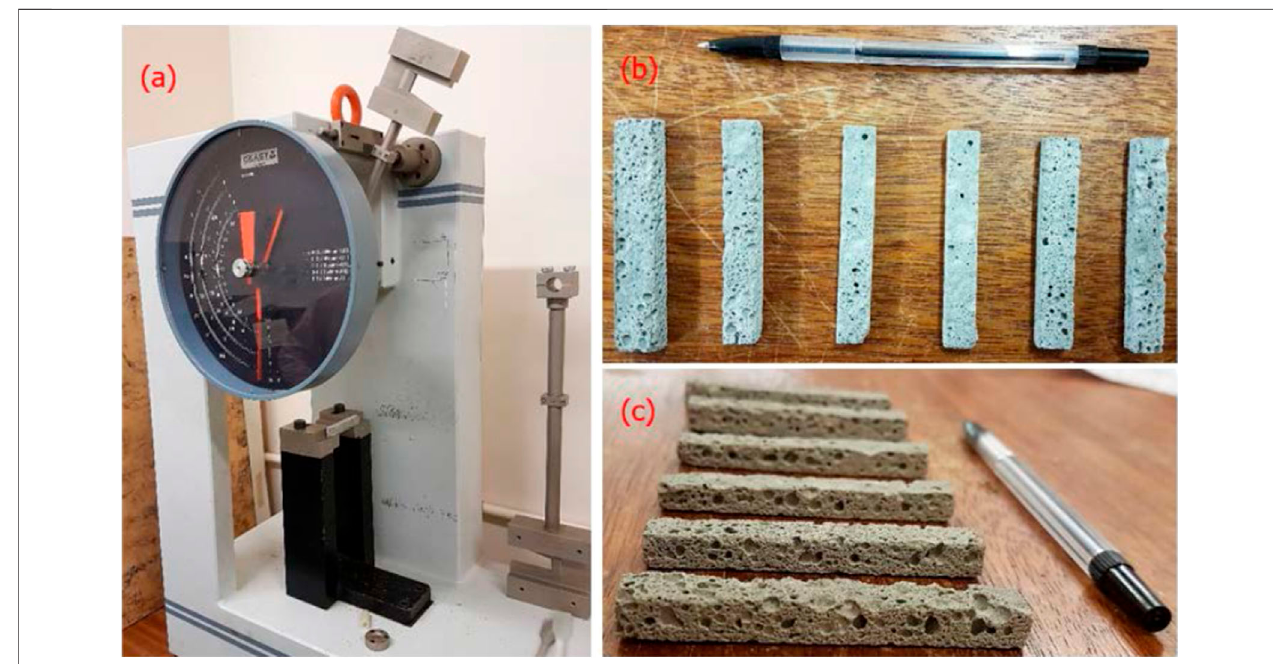
FIGURE 3 | (A) Setup of Charpy testing (CEAST Torino, United Kingdom) (B) , (C) view of samples cut out to an appropriate size from different angles.